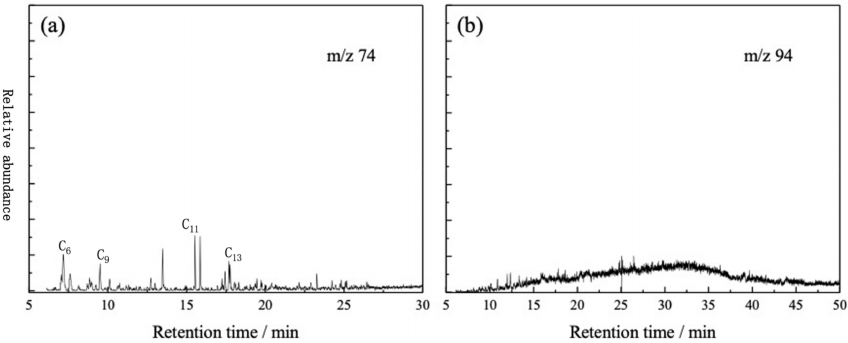
Figure 8. Spectrum of oxygen compounds. ( a ) The ion current spectra with m / z of 74; ( b ) The ion current spectra with m / z of